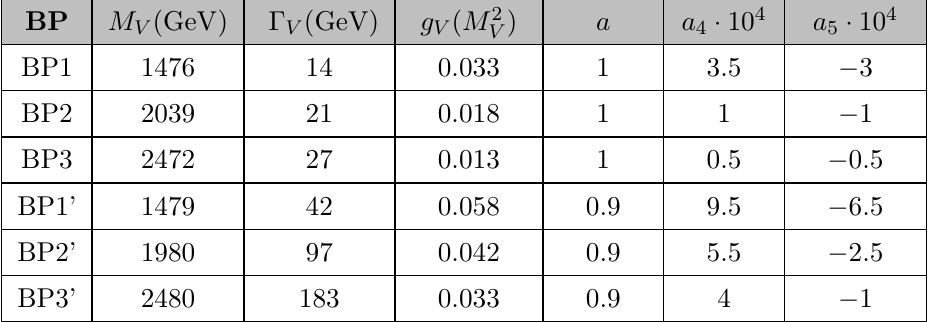
Table 1 . Selected benchmark points (BP) of dynamically generated vector resonances. The mass, M V , width, (cid:0) V , coupling to gauge bosons, g V ( M V ), and relevant chiral parameters, a , a 4 and a 5 are given for each of them. b is (cid:12)xed to b = a 2 . This table is generated using the FORTRAN code that implements the EChL+IAM framework, borrowed from the authors in refs. [20, 24, 25].